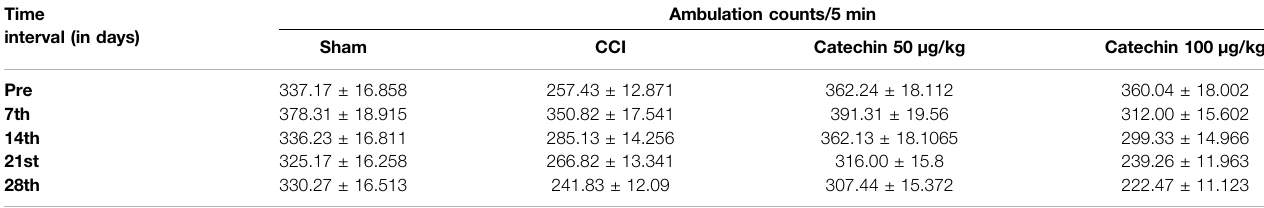
TABLE 2 | Effect of catechin on locomotor activity using an actophotometer. Time interval (in days)